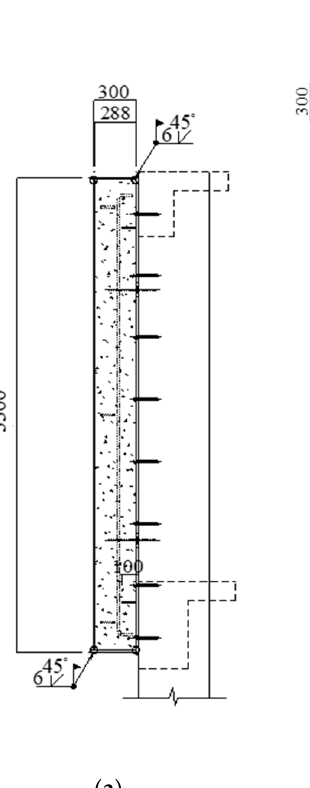
Figure 4. Drawing of the ERC specimen (mm). ( a ) Front view; ( b ) vertical cross-section.